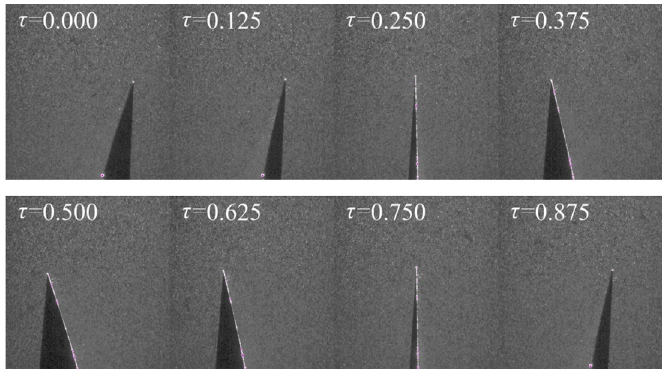
Figure 9. Position of PZT fan blade for eight phases in an oscillation period.